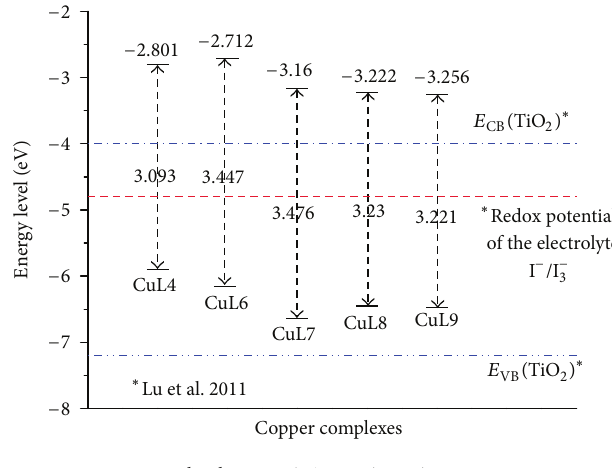
Figure 4: Molecular orbitals energy levels